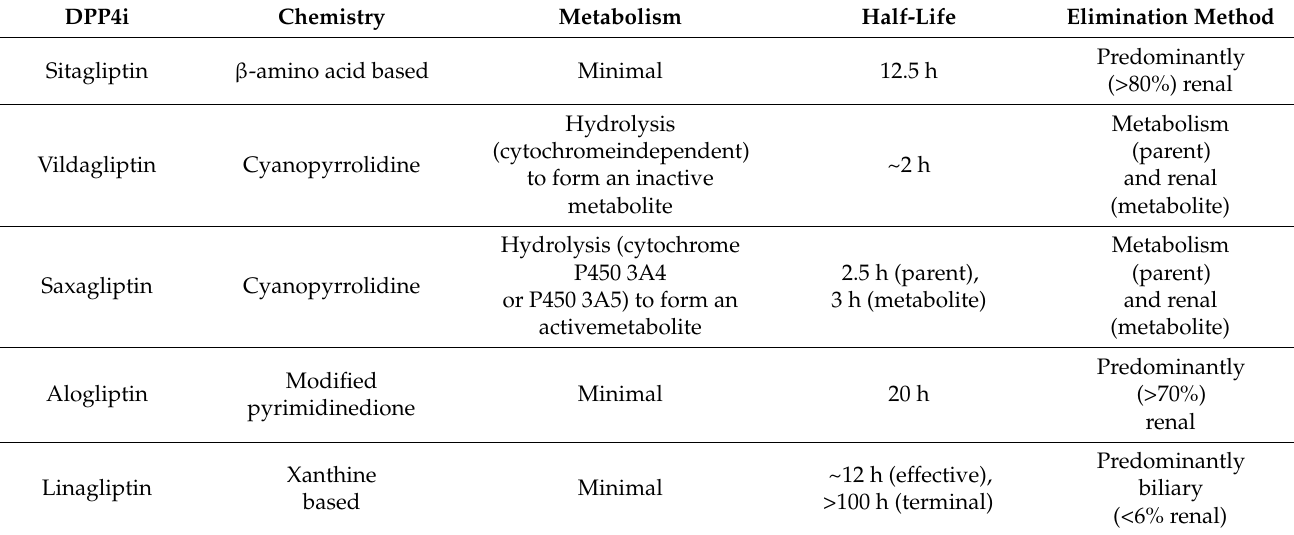
Table 1. The features of approved dipeptidyl peptidase 4 inhibitors